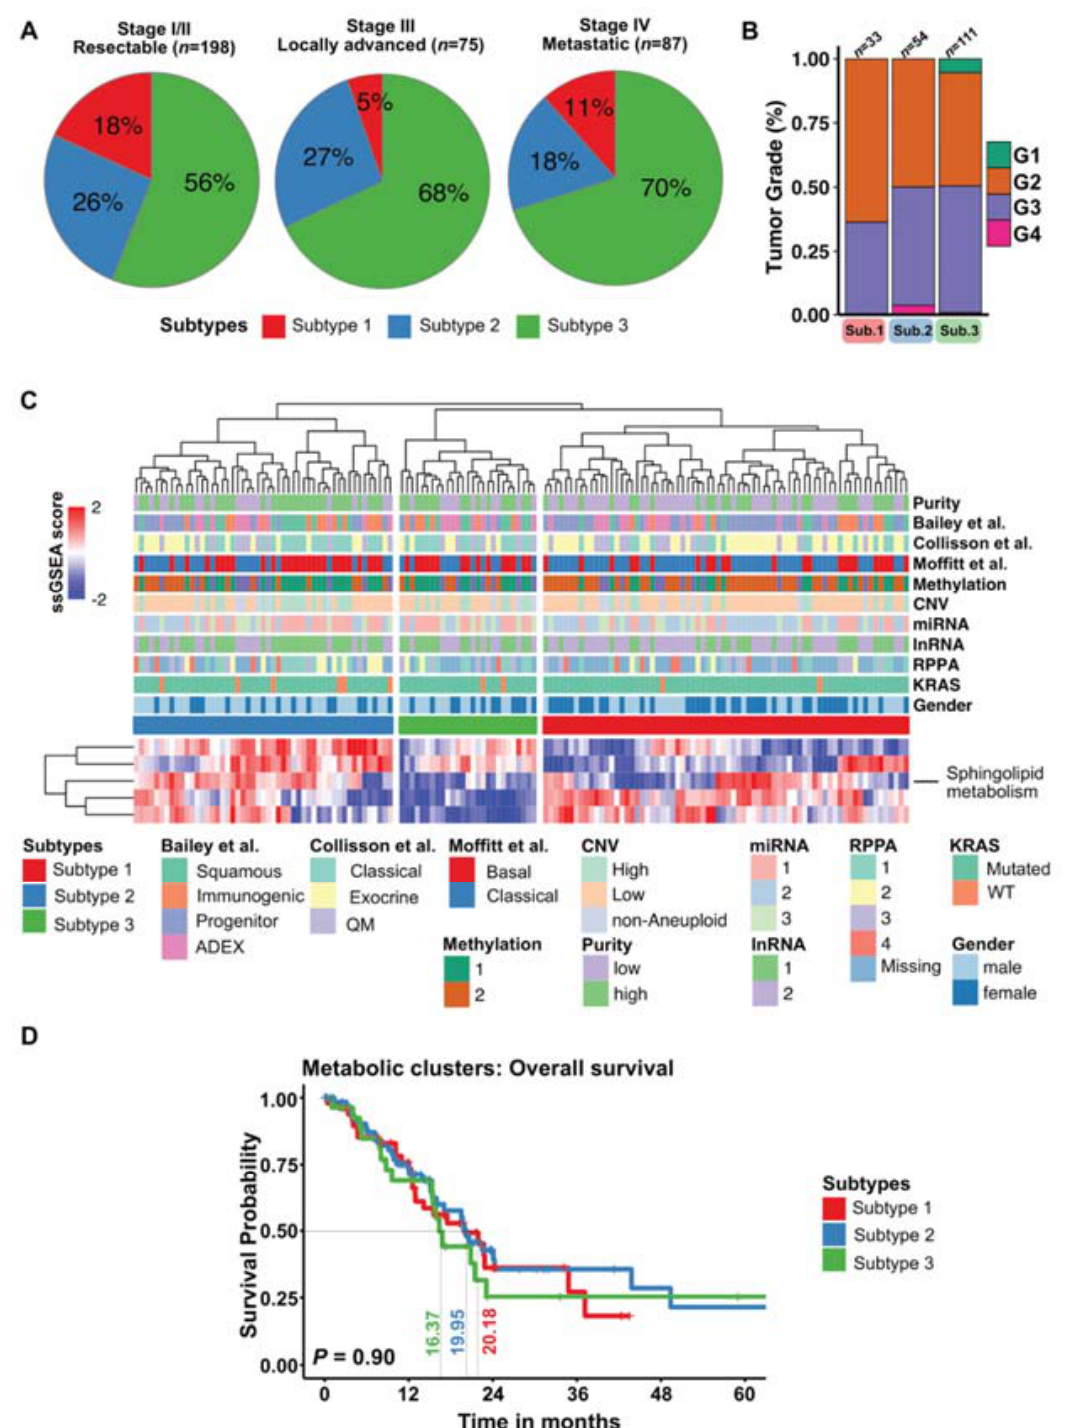
Figure 5. Correlation between TCGA-PAAD transcriptome and metabolic subtypes: ( A ) pie charts show proportions of metabolic subtypes in each clinical stage of PDAC. ( B ) Stacked bar plot of tumor grades for each metabolic subtype. ( C ) Consensus clustering heatmap was performed on metabolic genes associated with identified pathways in metabolite subtypes from the TCGA-PAAD data set. Clinical characteristics and transcriptomic subtypes associated with TCGA-PAAD were marked with color bars above heatmap. ( D ) Kaplan–Meier curves of cancer specific overall survival of individual subtypes delineated from TCGA-PAAD dataset. p < 0.05 is considered significant.